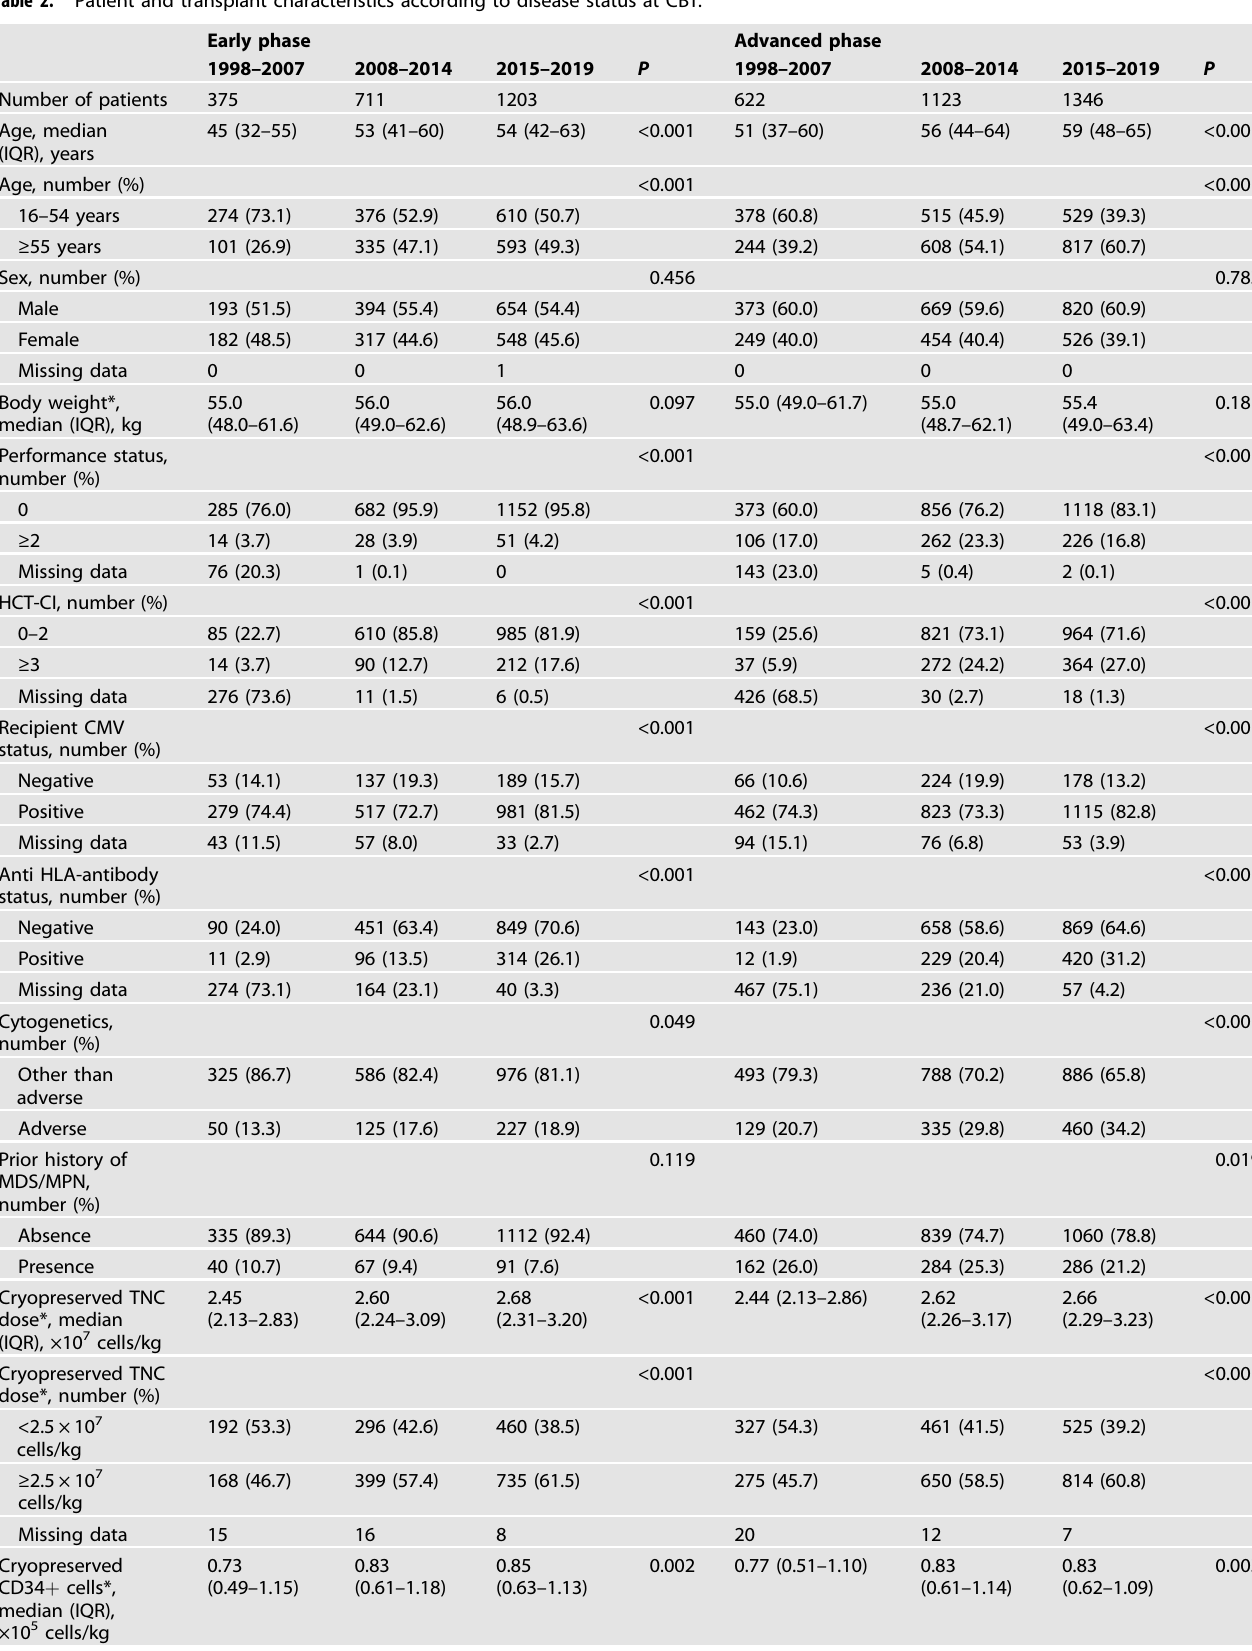
Table 2. Patient and transplant characteristics according to disease status at